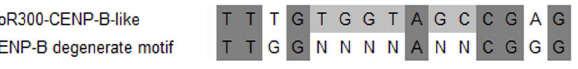
Figure 3. CENP-B like motif. Comparison of the CENP-B like motif (237–252 bp) found in BoR300 with the degenerate motif considered to